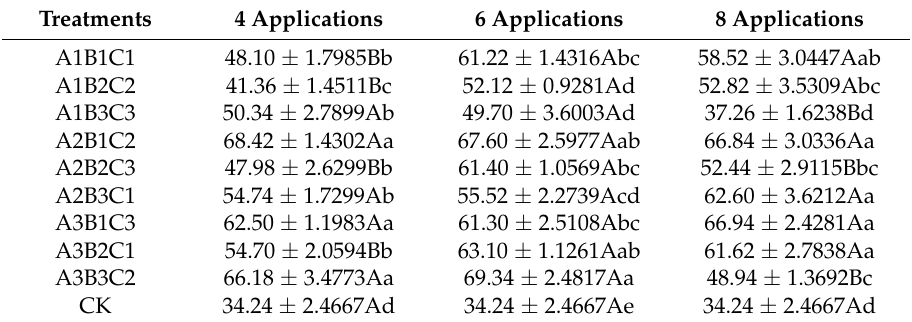
Table 4. Effects of different fertilization ratios and application frequencies on seedling